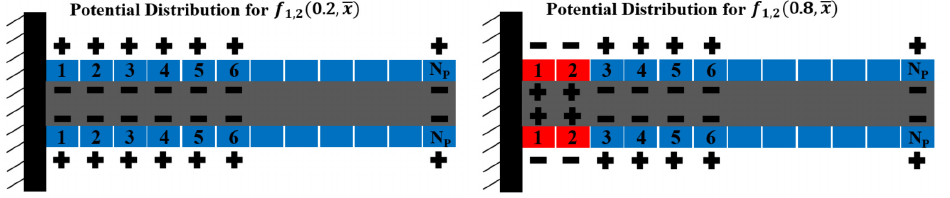
Figure 5. f 1,2 ( r , ¯ x ) —the optimal potential distribution for r = 0.2 and r = 0.8.